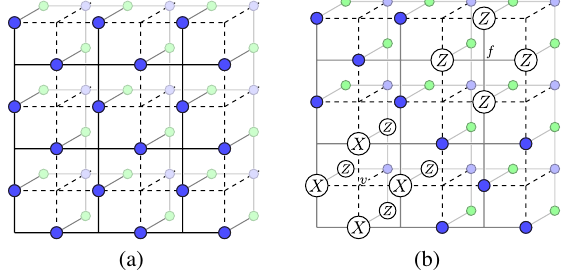
FIG. 4. (a) The boundary of the lattice consists only of dual qubits which are depicted in blue. Primal qubits on faces penetrating into the bulk are depicted in green. (b) The boundary ¯ ¯ B A terms and . In both figures, bold lines indicate nearest- v f neighbor relations, while dashed lines indicate edges of the cubic lattice. The dashed lines on the boundary can be thought of as the edges of a toric code